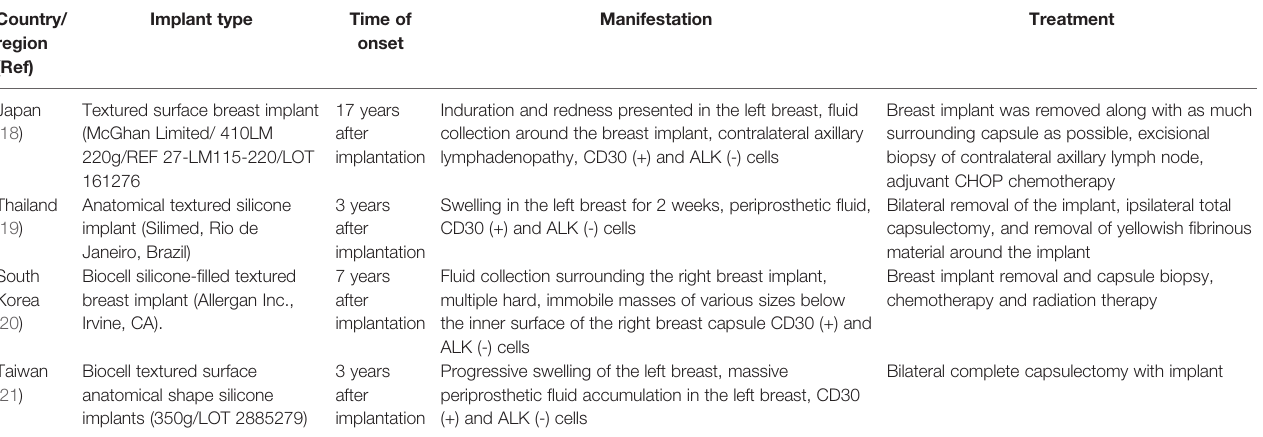
TABLE 1 | The detailed information of BIA-ALCL occurred in